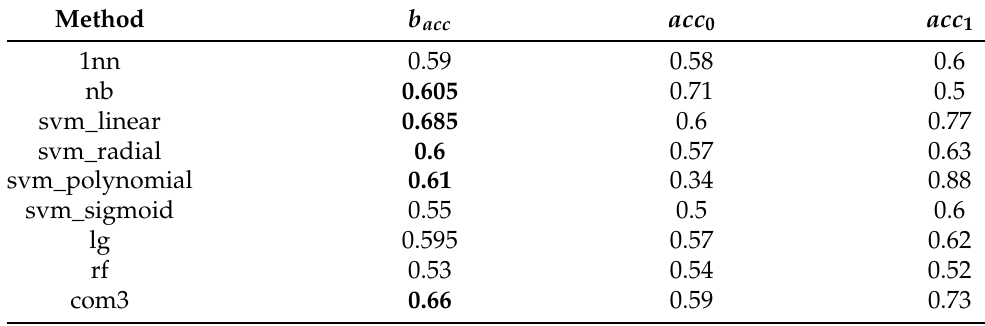
Table 9. Summary of results for data.bee2.3 with baseline correction.